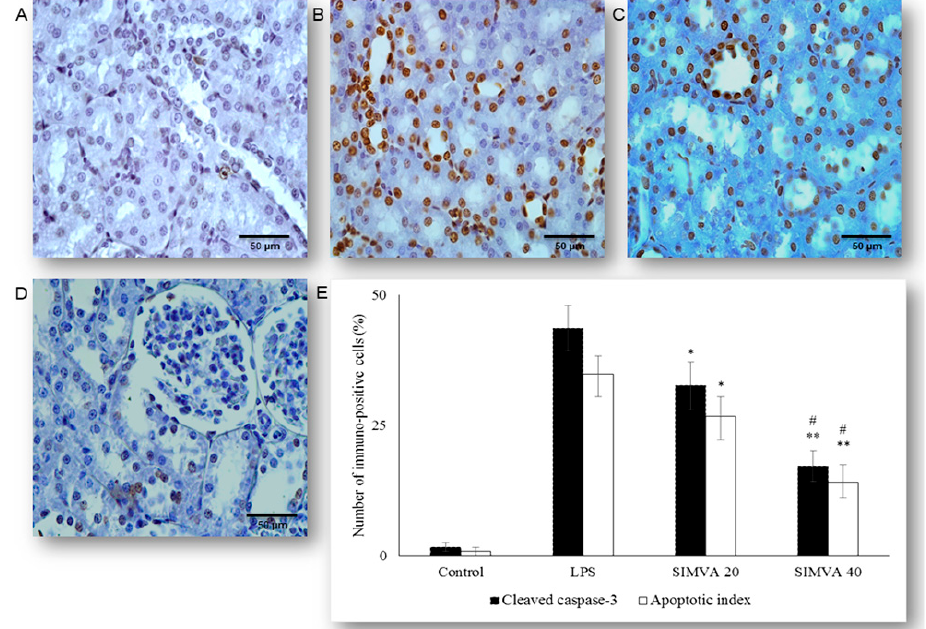
Figure 2. Representative images of apoptotic renal tubular epithelial cells that were challenged with LPS or pretreated with simvastatin prior to LPS, simvastatin 20 mg/kg or 40 mg/kg, respectively. Attenuation of the renal apoptosis induced by LPS shown as decreased cleaved caspase-3 expression in the tubular epithelial cells, assessed by immunohistochemistry, magnification 400x. ( A ) The control group, ( B ) intense cytoplasmic staining of cleaved caspase 3 in the tubular epithelium in the LPS group, as one of the feature of apoptotic cell, significant reduction of apoptotic cells in the groups treated with simvastatin 20 mg/kg ( C ) and 40 mg/kg, respectively ( D ).